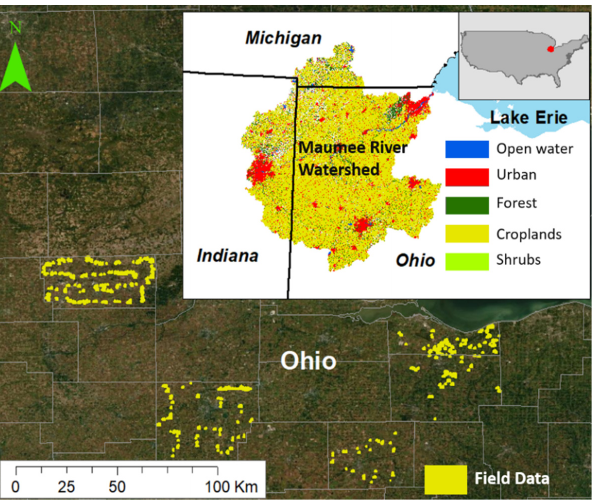
Figure 1. Maumee River watershed spreading over Ohio, Indiana and Michigan in the Midwest United States.